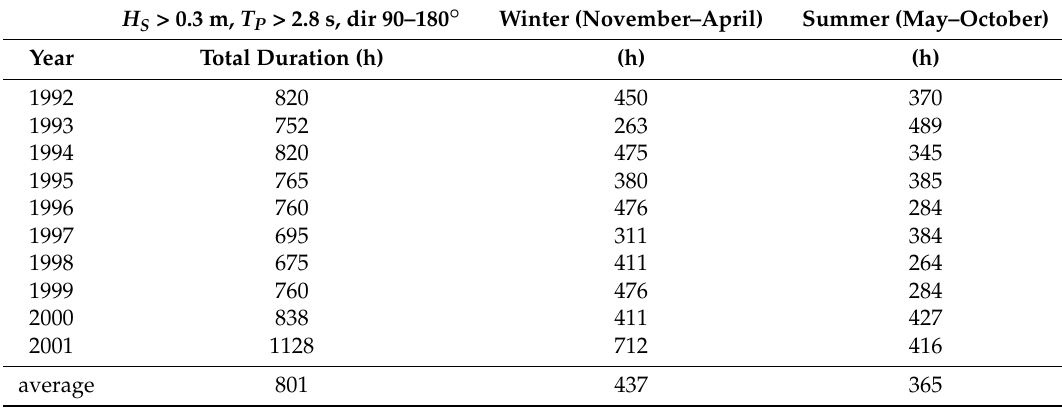
Table 5. An average number of hours per year (and per season) with recognised wind waves assuming criteria: H S > 0.3 m and T P > 2.8 s and incident wave direction in the band from 90° (E) to 180° (S) at the location of the marina Opatija.